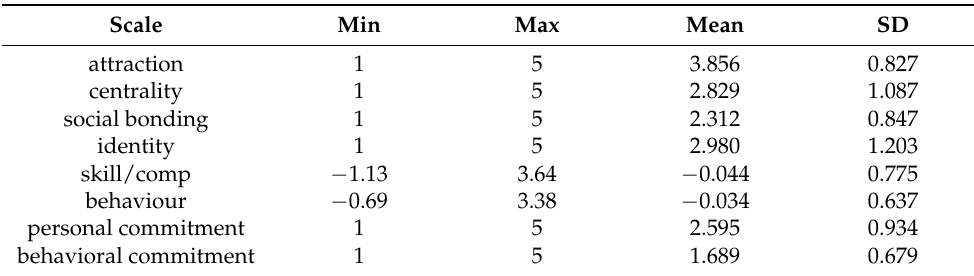
Table 1. Descriptive statistics for the sample. Scales are shown. Please note skill/competence and behavior haven been